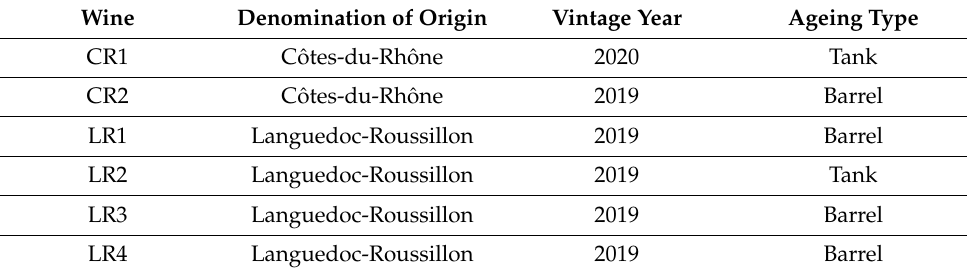
Table 1. General information on the six Shiraz wines